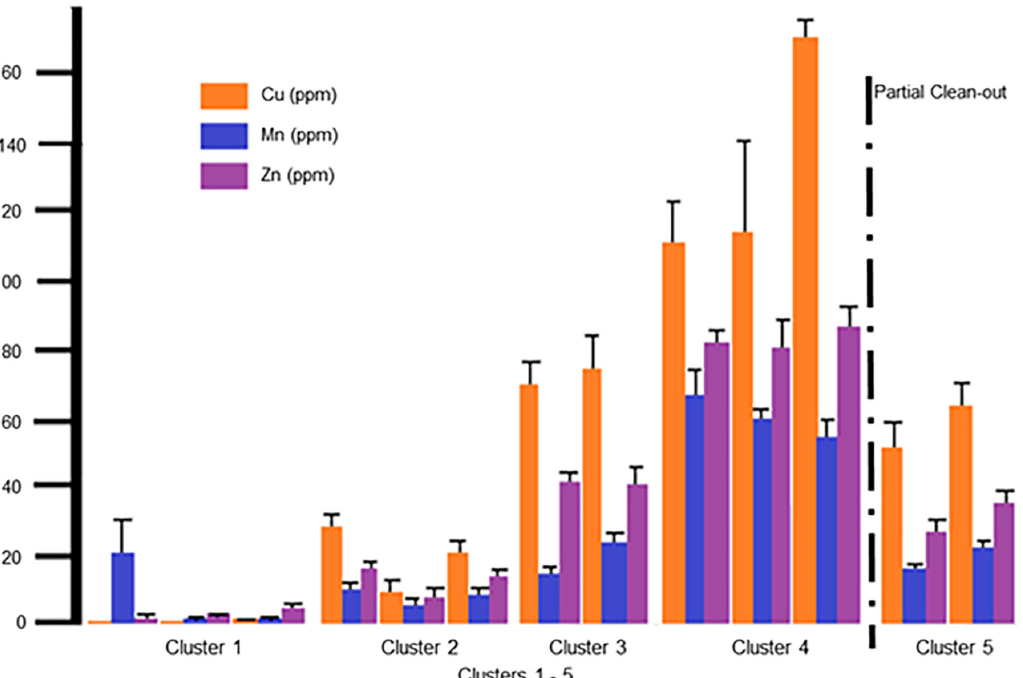
Fig 6. Mean values for the parameters Cu, Mn and Zn Mean values for the parameters Cu, Mn and Zn, expressed as ppm, with standard deviation error bars are seen in this graph. In order from left to right on the graph is Cluster 1: Native, Pad and Flock1; Cluster 2: Flock 2, 10 and 11; Cluster 3: Flocks 3 and 4; Cluster 4: Flocks 5, 6, and 7; and Cluster 5: Flocks 8 and 9. The partial clean-out which occurred between Flock 7 and 8 is marked by a dashed line.